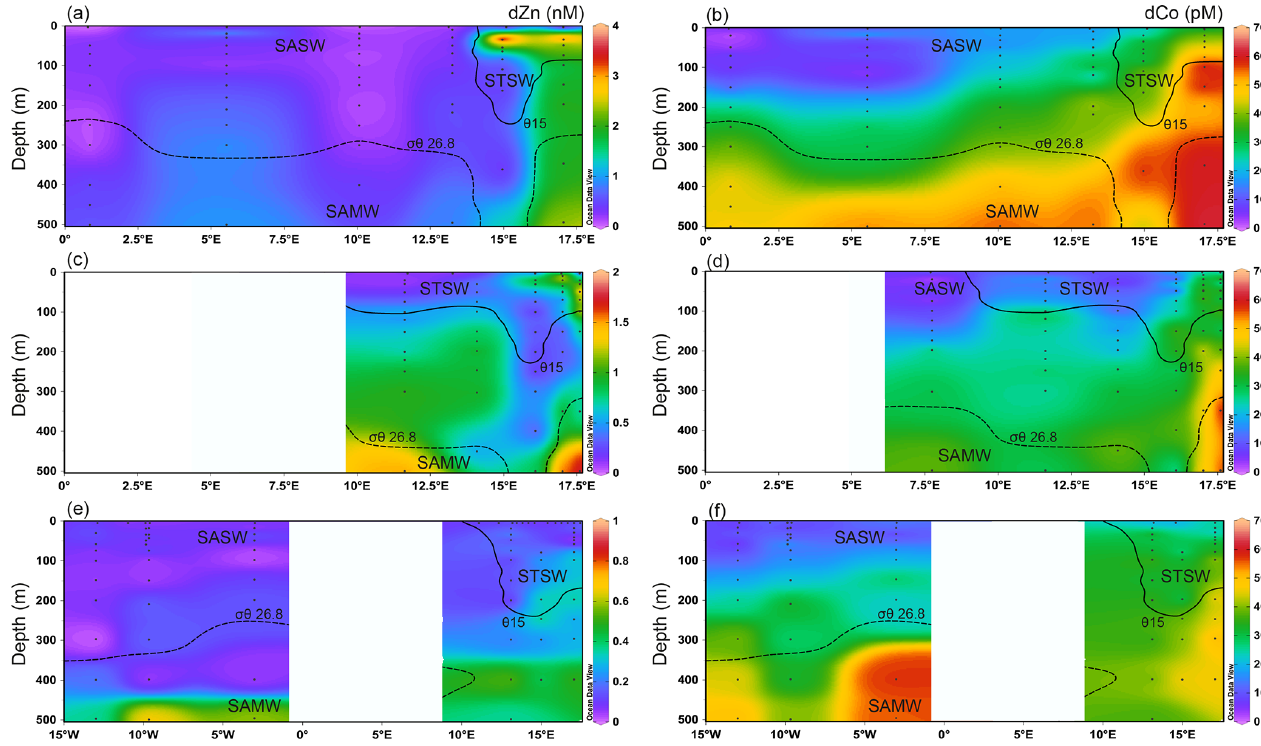
Figure 3. Upper 500m dissolved Zn and Co distributions for the south-eastern Atlantic along early-spring ( a, b ; D357-1), late-spring ( c, d ; D357-2) and summer ( e, f ; JC068) transects. The STF is delineated by θ 15 ◦ C (solid contour), whilst the influence of SAMW is evident by the median-potential-density ( σθ ) isopycnal (26.8kgm − 3 ; dashed contour; see Sect. 4.1.). STSW: sub-tropical surface water; SAMW: sub-Antarctic mode water; AAIW: Antarctic intermediate water. Note the changing y -axis scales for dZn